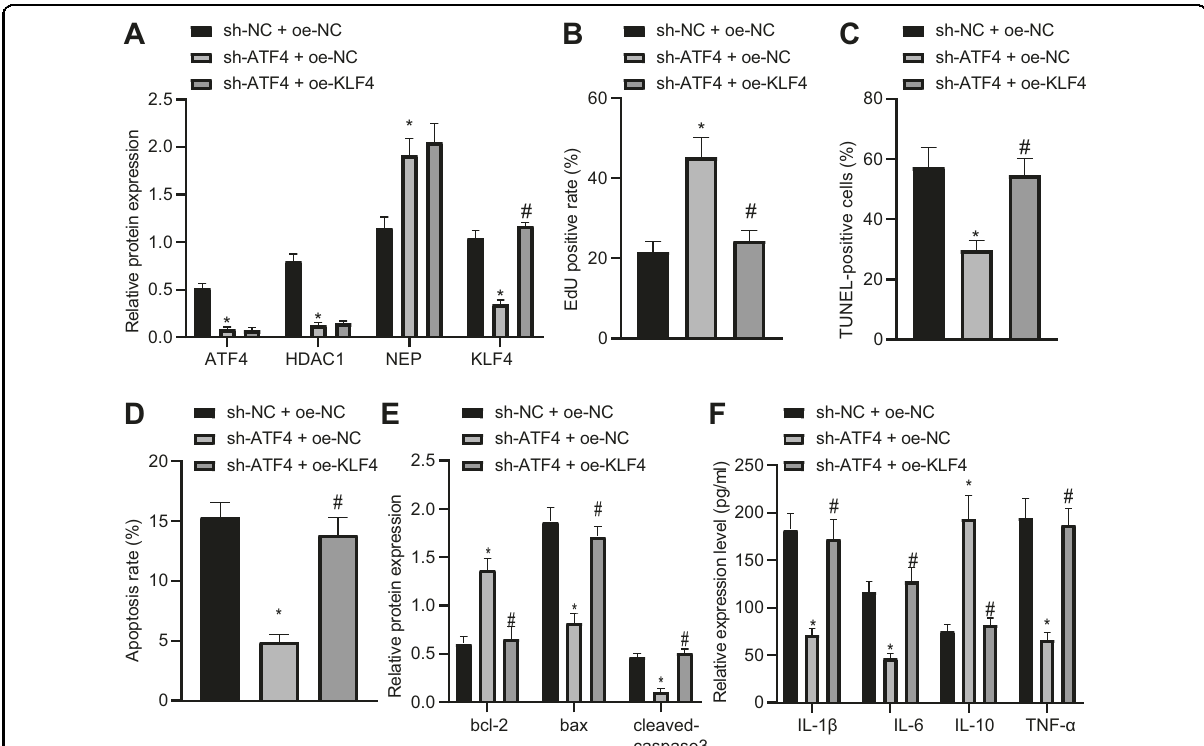
Fig. 7 Downregulation of ATF4 promotes pancreatic acinar cell proliferation via regulation of NEP-KLF4 expression by inhibiting HDAC1. A Western blot analysis was performed to detect ATF4, HDAC1, NEP, and KLF4. B EdU was applied to detect pancreatic acinar cell proliferation after sh- ATF4 or oe-KLF4 treatment. C TUNEL was performed to detect pancreatic acinar cell apoptosis after sh-ATF4 or oe-KLF4 treatment. D Flow cytometry was performed to detect pancreatic acinar cell apoptosis after sh-ATF4 or oe-KLF4 treatment. E Western blot analysis was performed to detect expression of Bcl-2, Bax, and cleaved-caspase3. F ELISA was conducted to test levels of IL-1 β , IL-6, TNF- α , and IL-10. * p < 0.05 compared with the sh- NC + oe-NC group; # p < 0.05 com p ared with the sh-ATF4 + oe-NC group. The comparison of the measurement data (mean standard ± deviation) among multiple groups was analyzed by one-way analysis of variance with Tukey ’ s post hoc